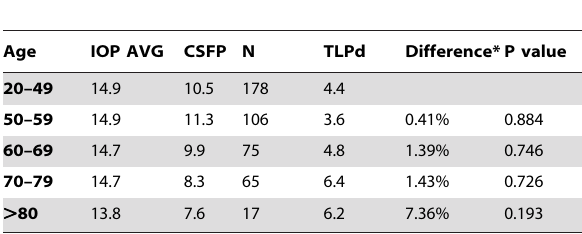
Table 6. Intraocular pressure, cerebrospinal fluid pressure, and translaminar pressure difference by age